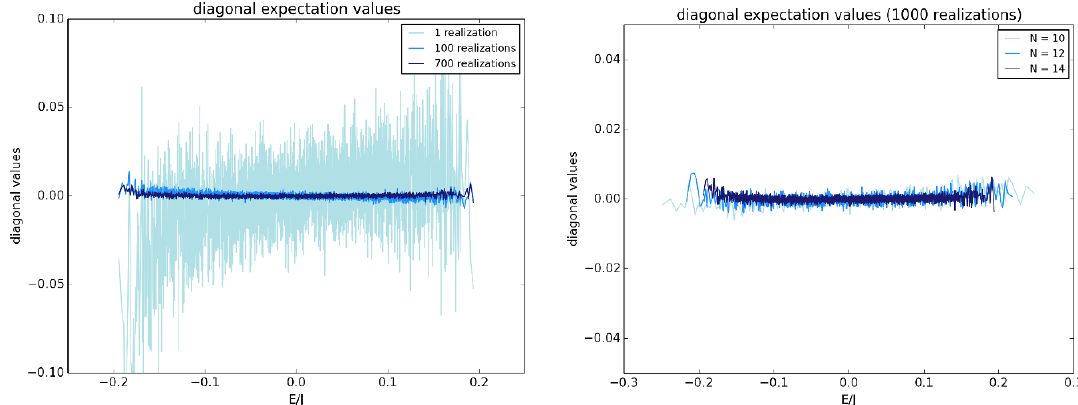
Figure 9 . Diagonal expectation values for the two-site hopping operator h N (cid:0) 1 ;N , at half (cid:12)lling (cid:23) = 1 . Left panel : the e(cid:11)ect of averaging of the random couplings at given (cid:12)xed Hilbert space 2 dimension, N = 14. As expected the on-diagonal values of the ensemble approach closer and closer to a smooth curve. Right panel : a single random realization for increasing Hilbert space dimension corresponding to N = 12 ; N = 14 ; N = 16. We see that the on-diagonal expectation values of a single realization approaches closer and closer to a smooth curve.